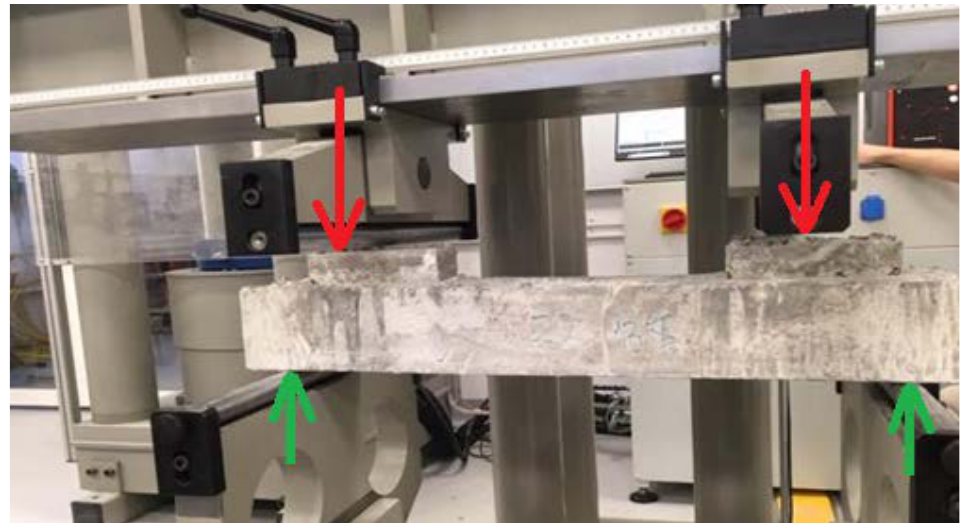
Figure 9. Laboratory sample prepared for testing.